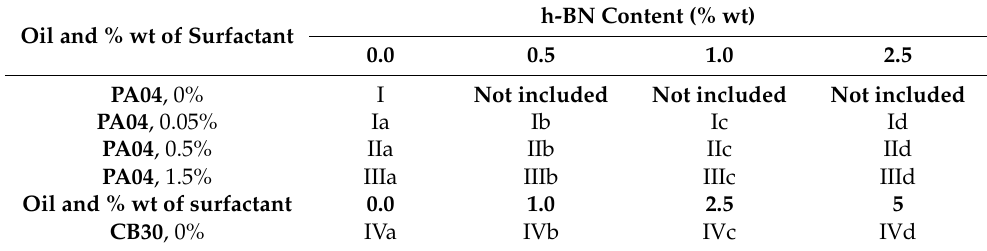
Table 5. Summary of test oil mixture compositions.